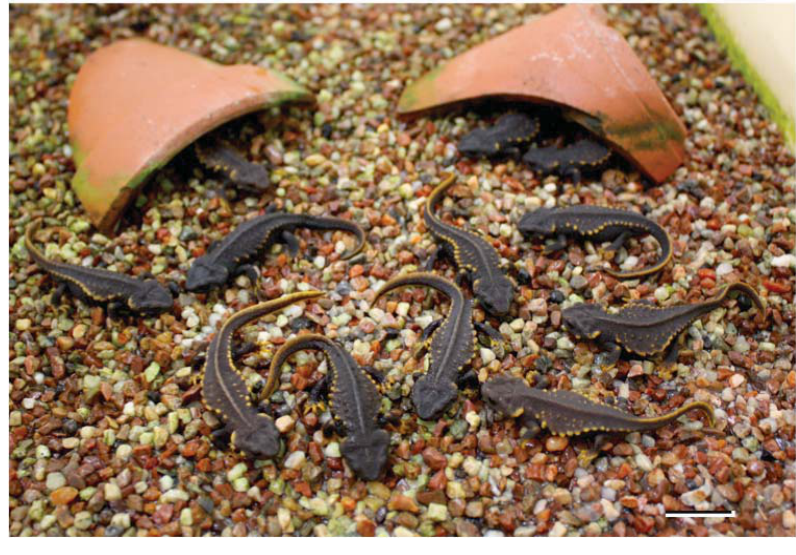
Figure 8. Three-year-old newts (body length 8–9 cm) produced by captive breeding and raised in the laboratory. Scale bar = 2.0